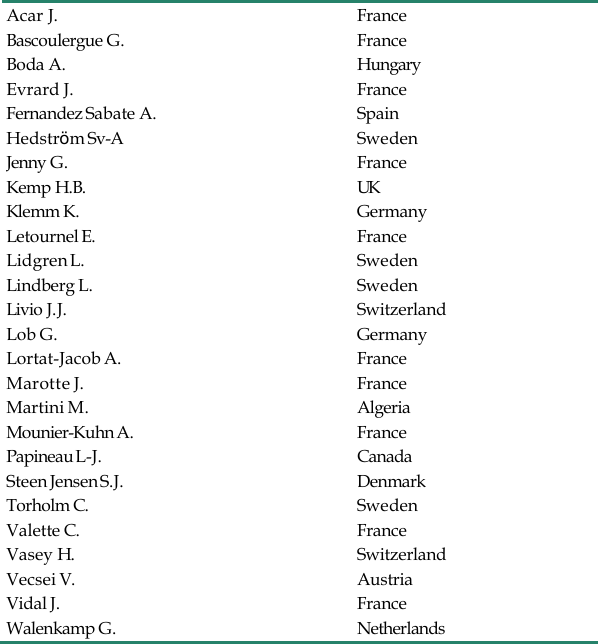
Table 1. 26 founding members of the Study Group in 1982 Acar